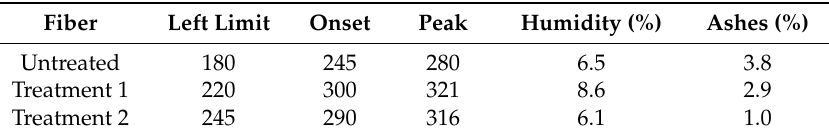
Figure 4. TG and DTG curves. Table 6. Degradation temperatures (in ˝ C) of virgin and treated banana